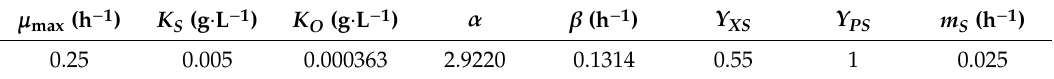
Table 1. Values for constants in bioreaction kinetic